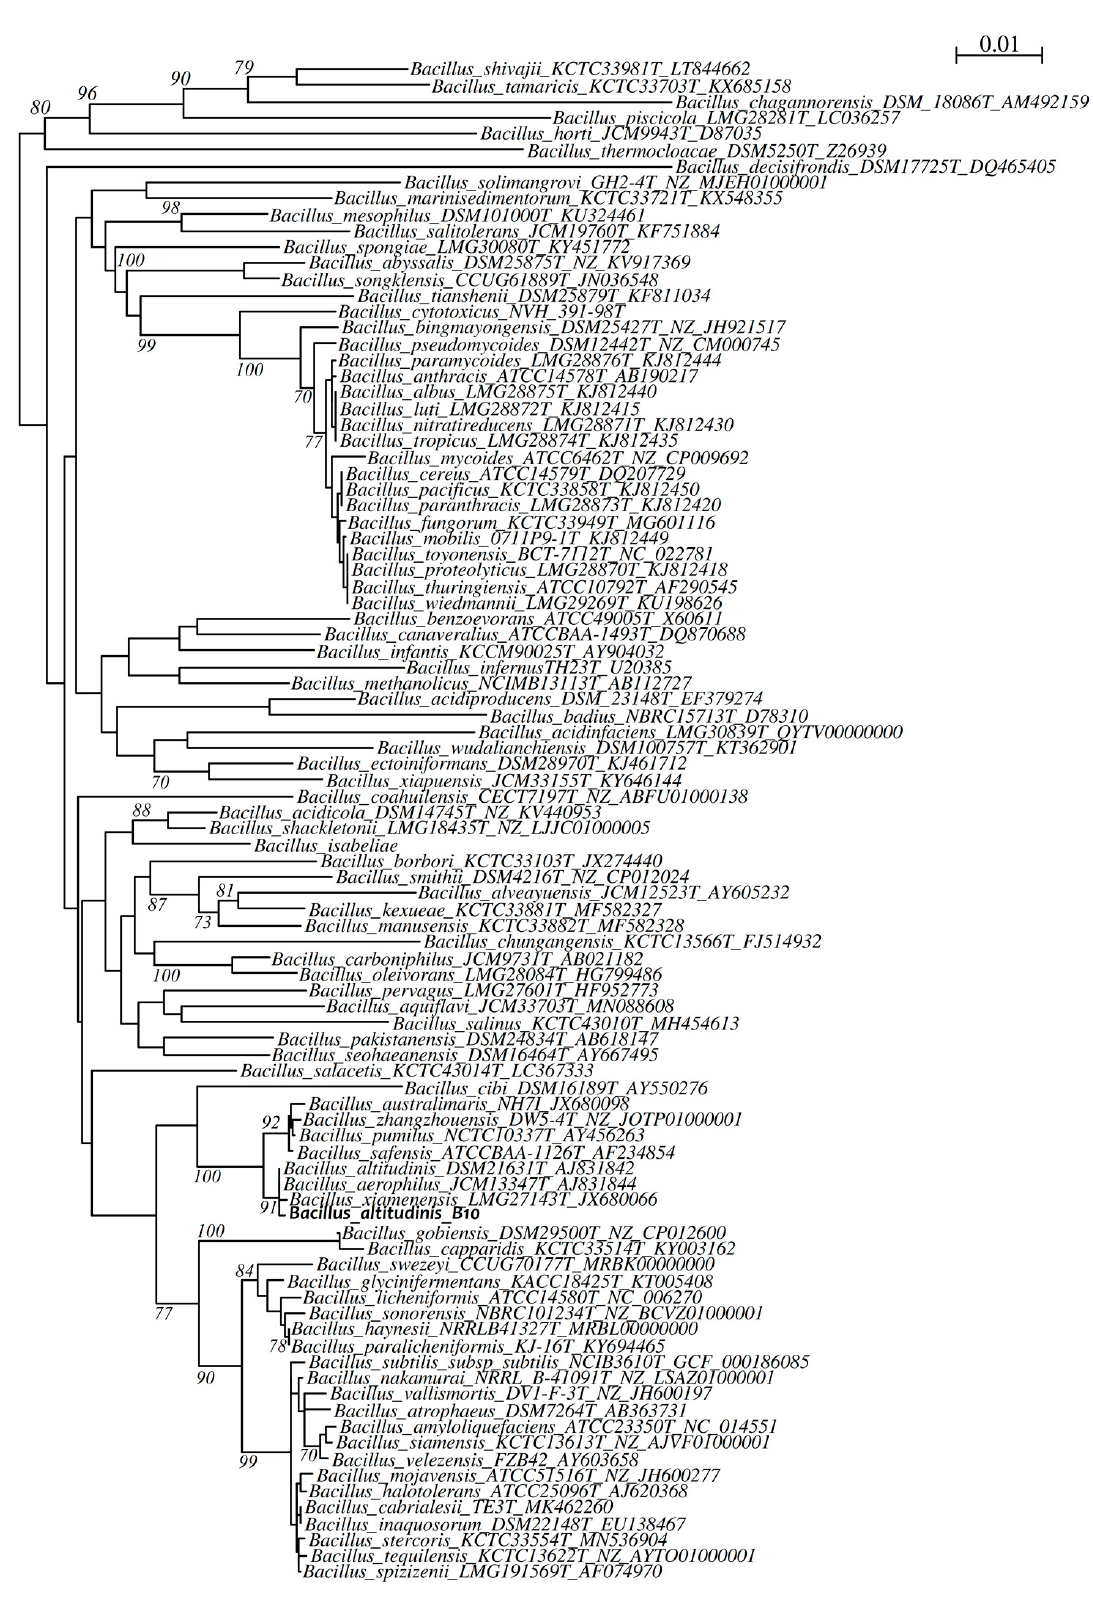
Figure 3. Neighbor-joining phylogenetic tree based on 16S rRNA gene sequences showing the positions of the B10 isolate belonging to B. pumilus group and the type strains of the genus Bacillus. Bootstrap values >70 are shown above branches. Bar: 0.01 substitutions per nucleotide position. Sequence accession numbers are given following strain